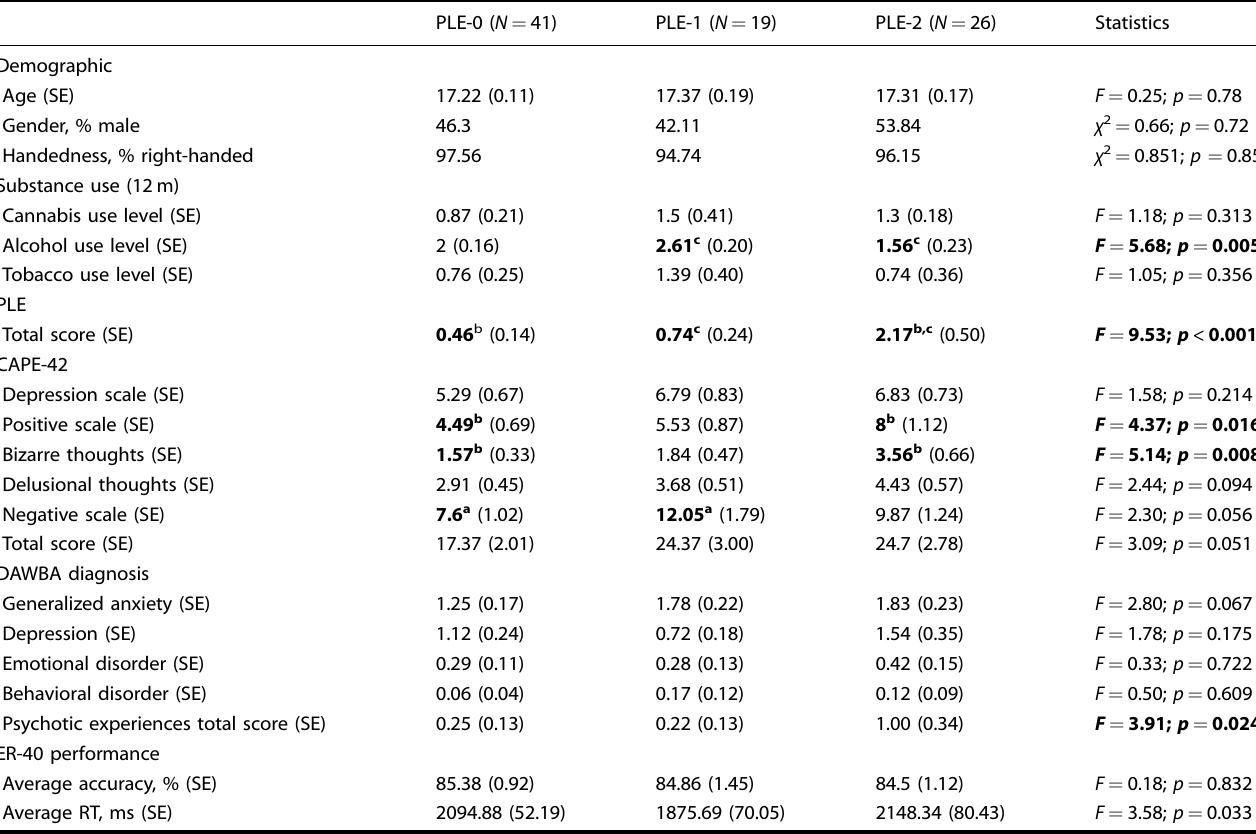
Table 1. Demographic and clinical